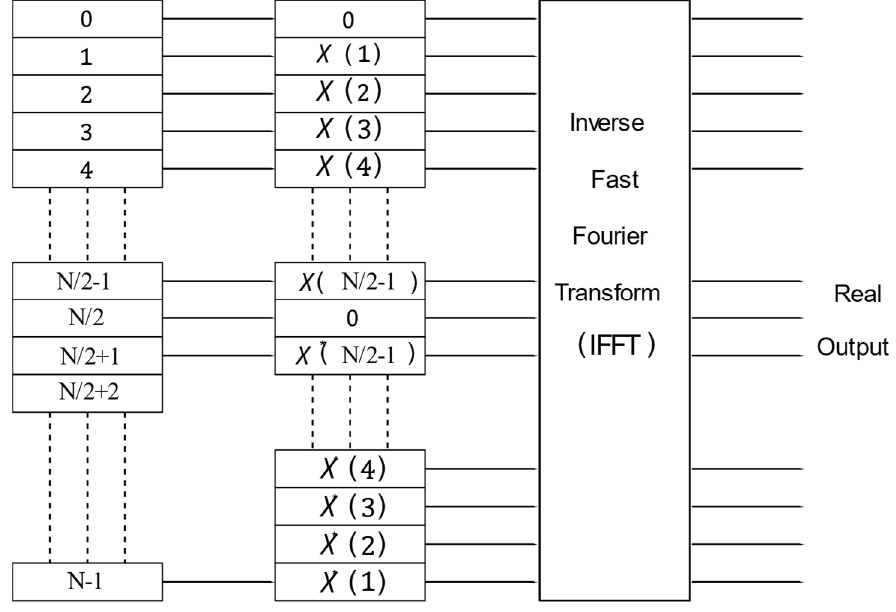
Figure 3. Hermitian symmetry (HS).